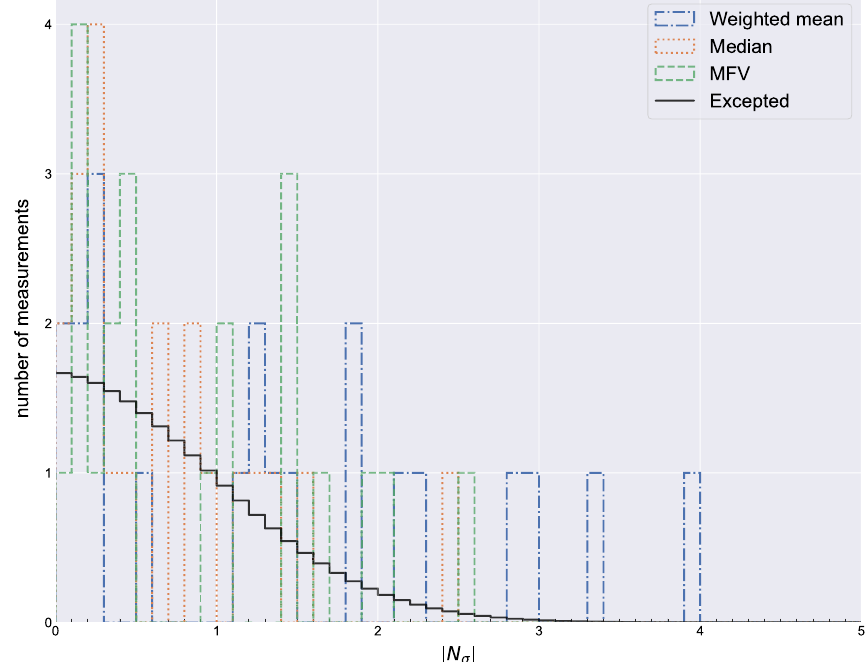
Fig. 7 Histogram of the error distribution in | N σ |= 0 . 1. The solid black line indicates the expected Gaussian probabilities for all data and the dash-dotted, dash, and dot lines denote the numbers of | N σ | values for the weighted mean, MFV, and median,